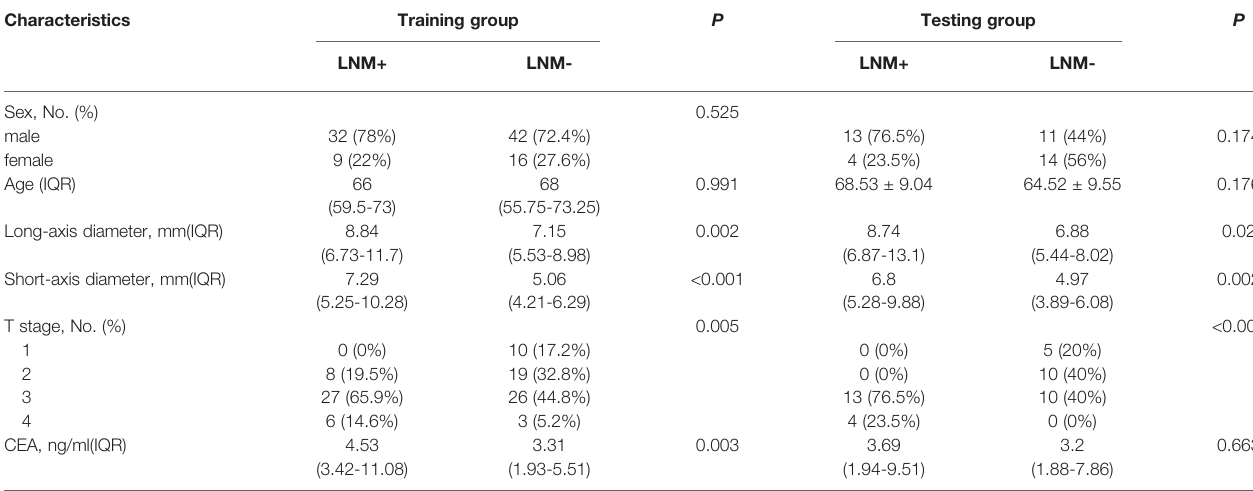
TABLE 3 | Study sample demographics and clinical characteristics of patients with LNM+ and LNM- rectal cancer.